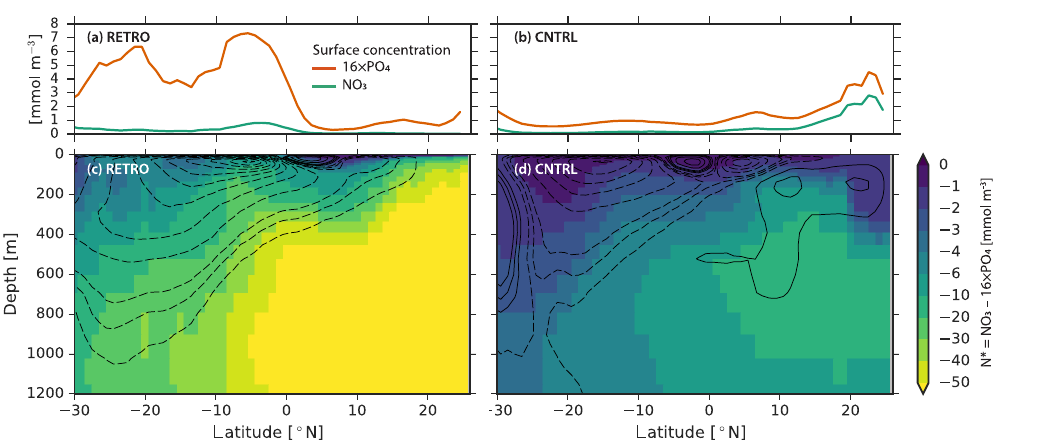
Figure 18. Zonal means in the Indian Ocean for RETRO (a, c) and CNTRL (b, d) : nitrate (green) and phosphate ( · 16, red) concentra- tions (a, b) (mmolm − 3 ), and N ∗ = NO 3 − 16 · PO 4 (c, d) in the Indian Ocean. Contours of MOC are overlaid at levels of ± 1, 2, and multiples of